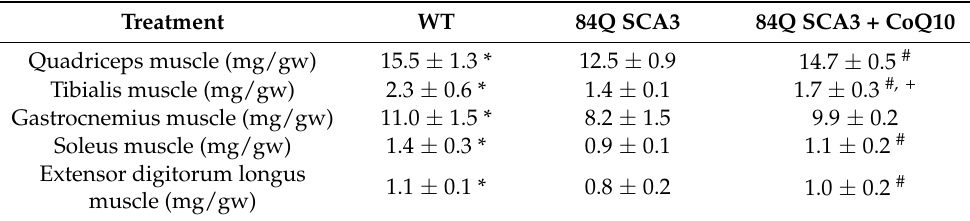
Table 1. Effects of CoQ10 on the muscle mass/body weight ratio in 84Q SCA3 mice a . Treatment